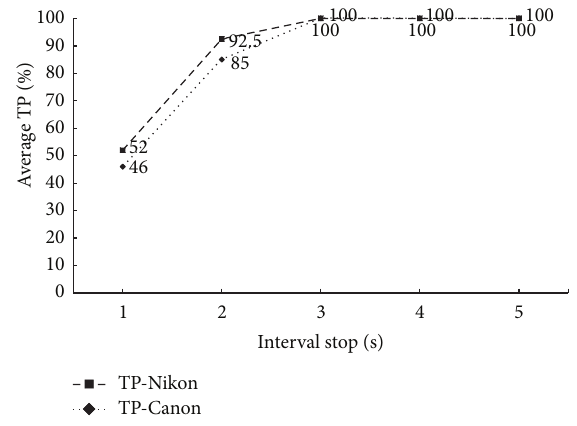
Figure 13: TP rate in different interval stop(s).